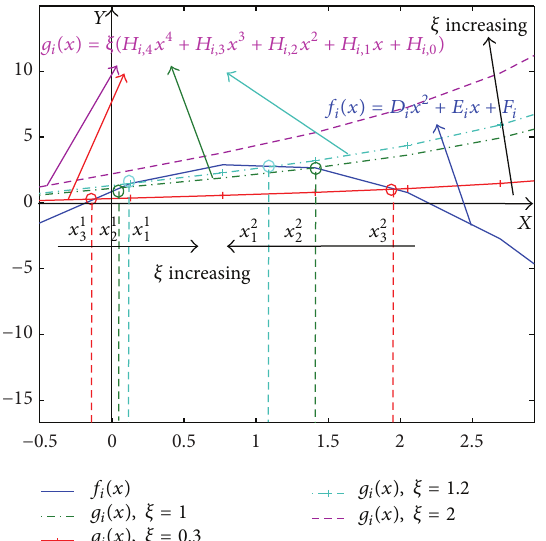
Figure10:Thelegendof 𝑓 𝑖 (𝑝 𝐵 𝑖 ) and 𝑔 𝑖 (𝑝 𝐵 𝑖 ) ,whereweuse 𝑥 todenote variable 𝑝 𝐵 𝑖